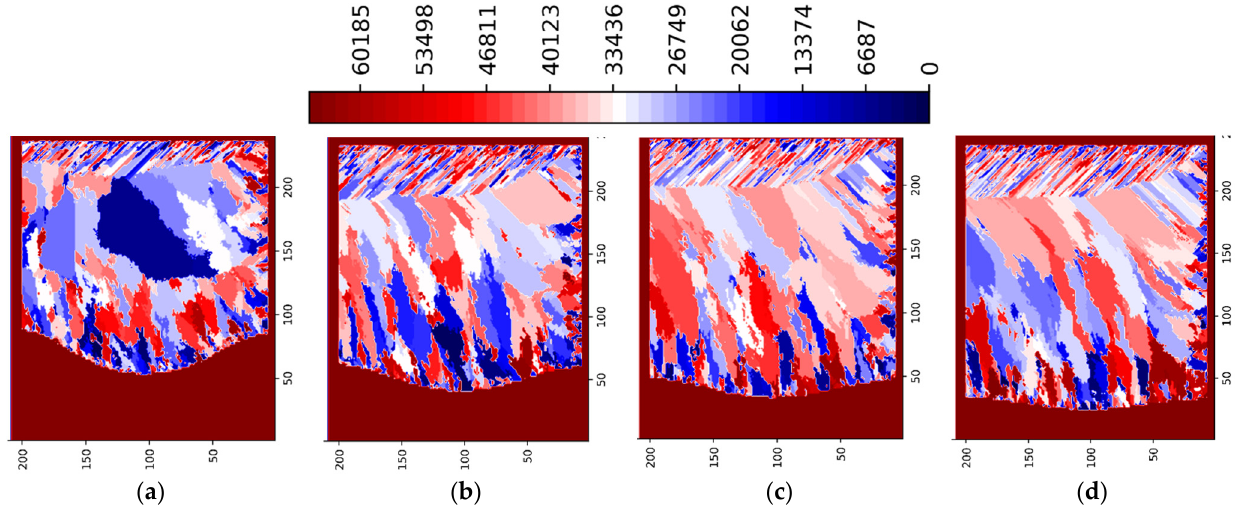
Figure 8. LPBF IN718 simulated grain structure (3 layers, 5 tracks)—ZY plane—layer 3 track 5: ( a ) P = 125 W; ( b ) P = 187.5 W; ( c ) P = 250 W; ( d ) P = 375 W.